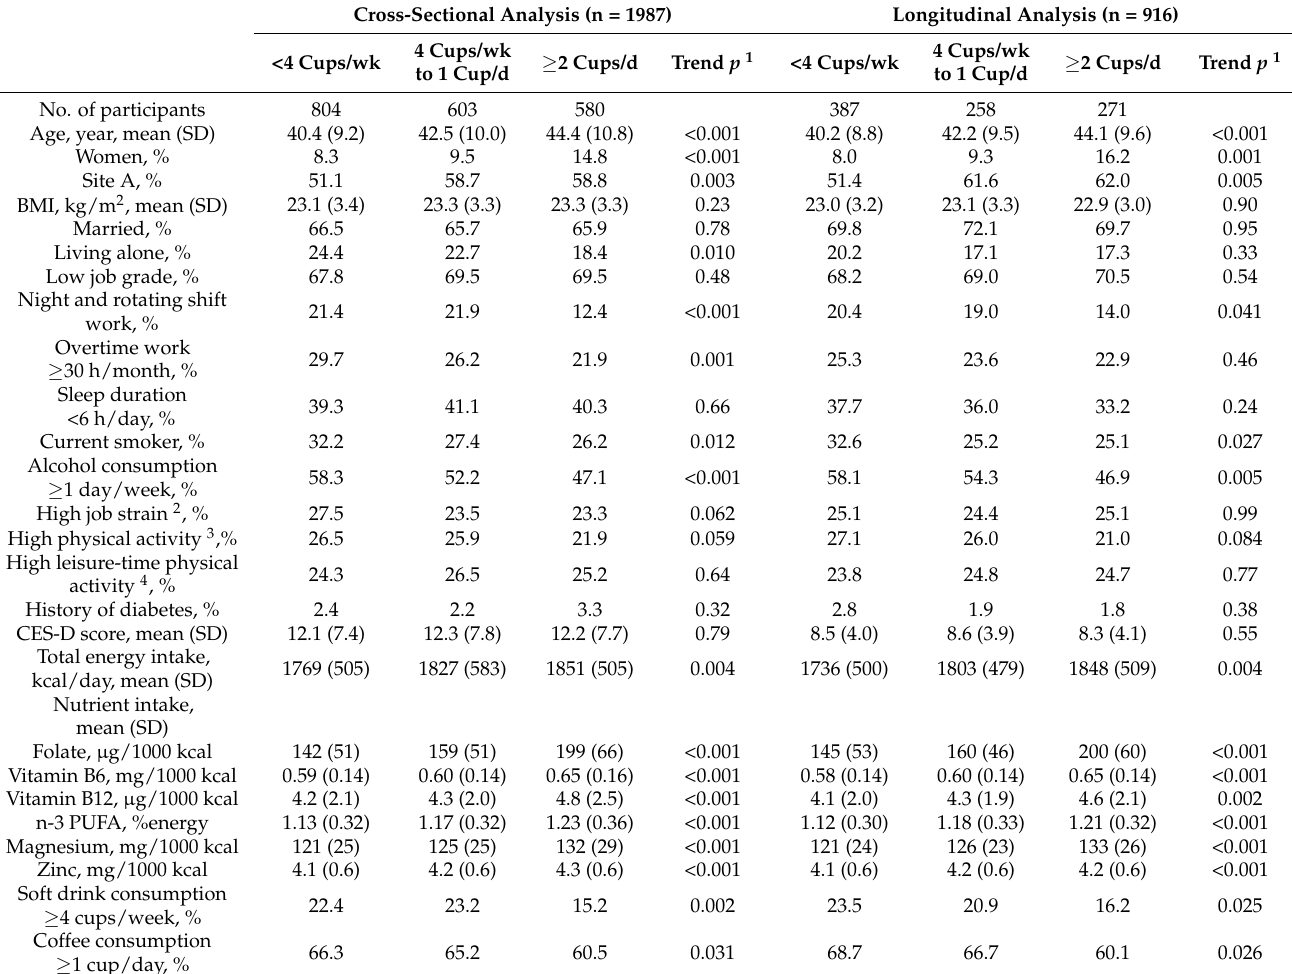
Table 1. Characteristics of participants by category of green tea